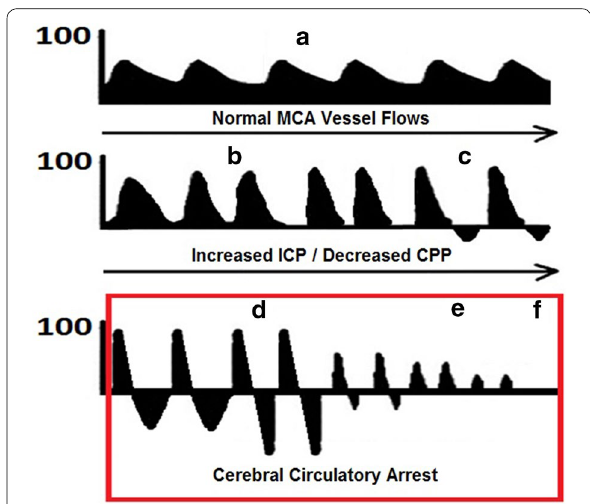
Fig. 6 Progression of intra-cranial circulatory arrest via transcranial Doppler of middle cerebral artery flows. a Normal systolic upstroke with normal step-down of diastolic flow. b Increased peak systolic flow with decreasing diastolic flow and eventual blunting of diastolic flow. c Diastolic flow reversal. d Biphasic or oscillating flow—where diastolic flow reversal approaches equal size to systolic flow. e Isolated sharp systolic peak flows of < 200 ms and small systolic amplitude of < 50 cm/s. f Zero flow—where there was previously documented TCD flow. The red box denotes states ( d , e , f ) in which cerebral circulatory arrest can be diagnosed